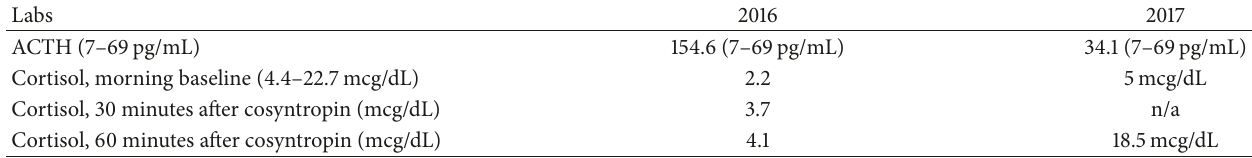
Table 1: Comparison of labs just after discontinuation of posaconazole and a year